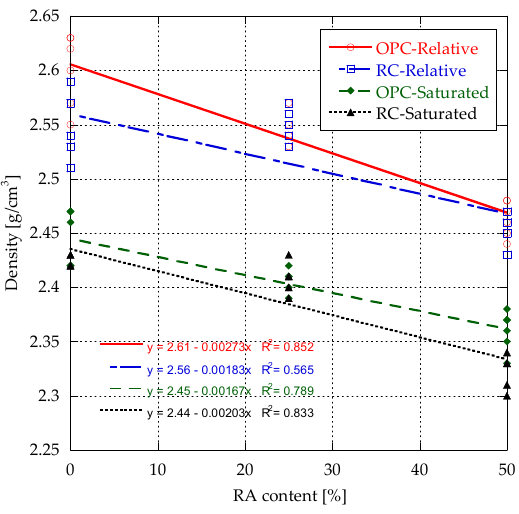
Figure 4. Density vs. RA content.